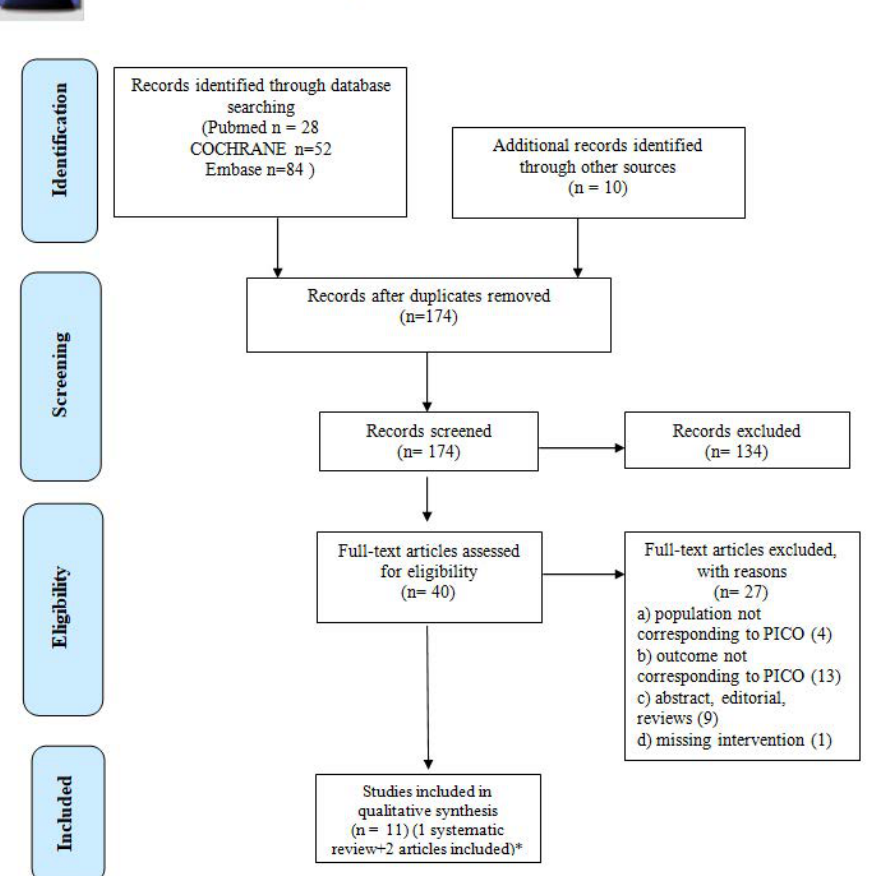
Figure 1. PRISMA 2009 Flow diagram for PICO A: cardiotoxicity incidence. * Of 13 included studies, 2 studies [7,8] were included in Stone’s systematic review [33] and were not evaluated separately. The results are summarized in Table